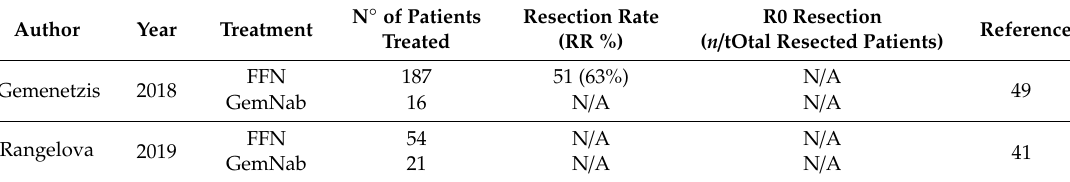
Table 6. Studies both FFN and GemNab included in the systematic